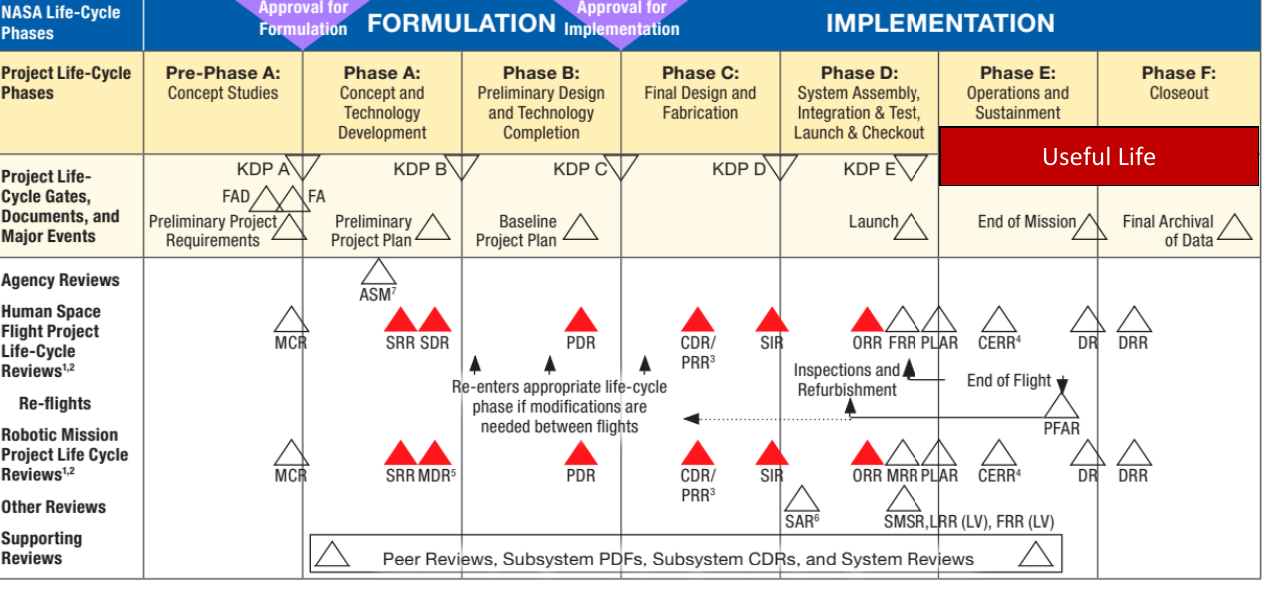
Figure 2. Example system lifecycle diagram from the NASA Systems Engineering Handbook . U.S. Government document, not subject to